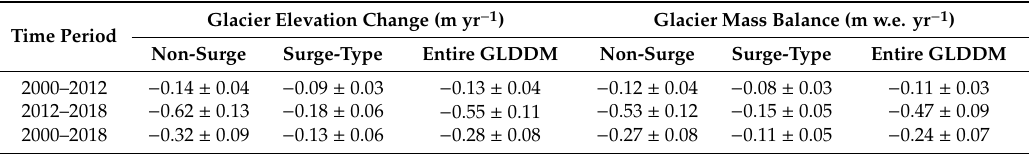
Table 2. Glacier elevation changes and mass balances of the Geladandong mountain(GLDDM) in